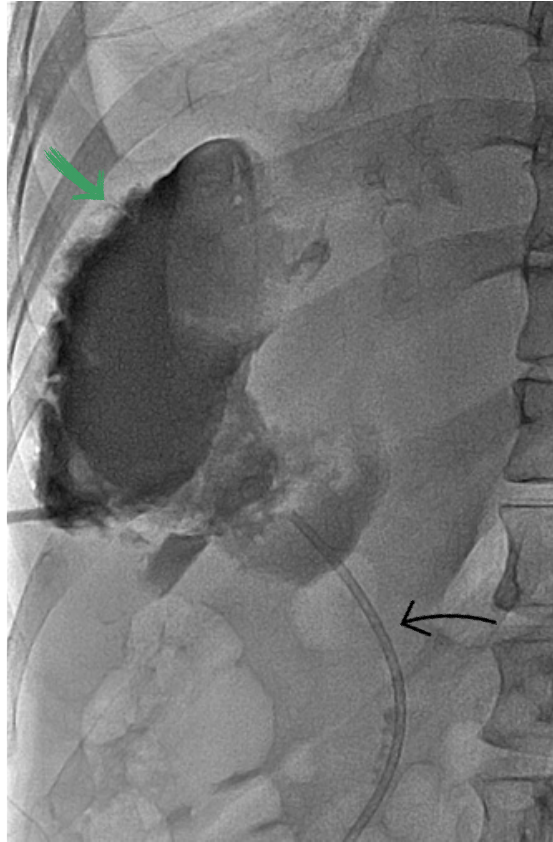
Figure 3. Contrast opacification of the subcapsular collection through the 8F pigtail catheter (green arrow). Previously placed stent in the common bile duct (black arrow).